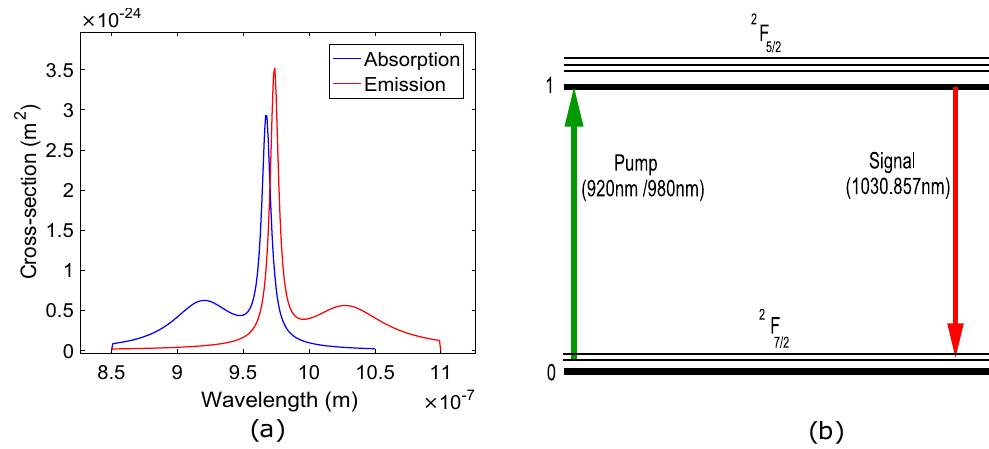
Figure 1. ( a ) Absorption and emission cross section of Yb 3 + ; ( b ) energy level diagram of Yb 3 +